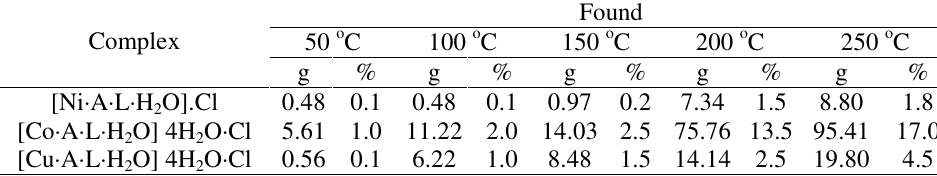
Table 4. Cumulative weight loss data of metal complexes at 50 o C to 250 O